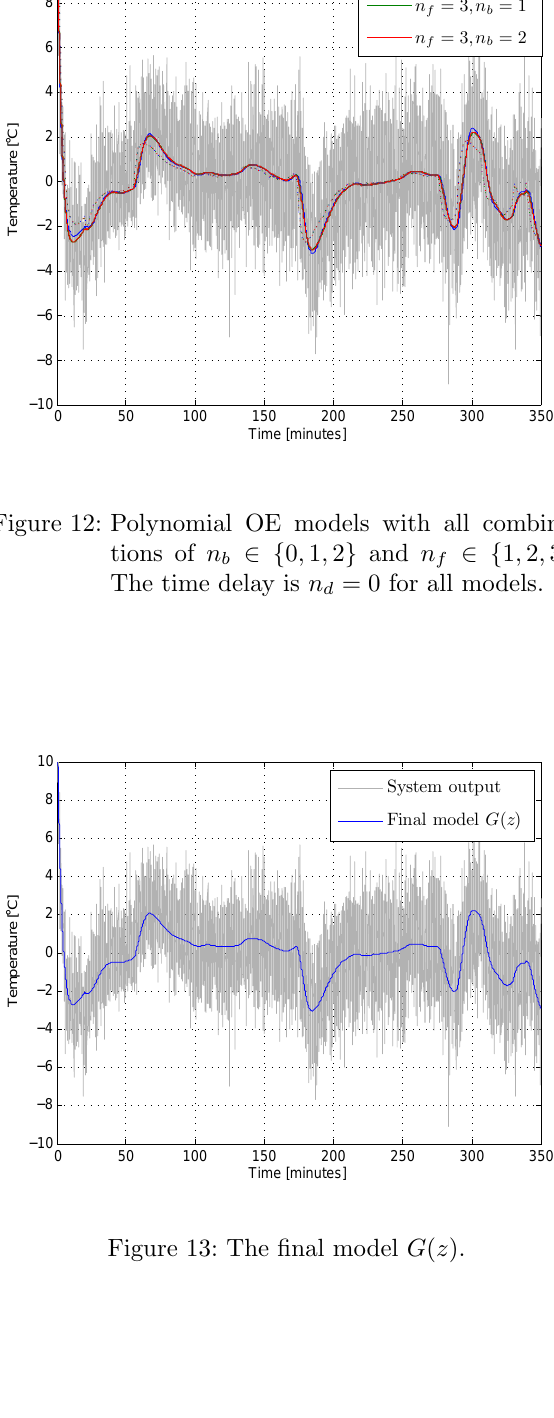
Figure 13: The final model G ( z